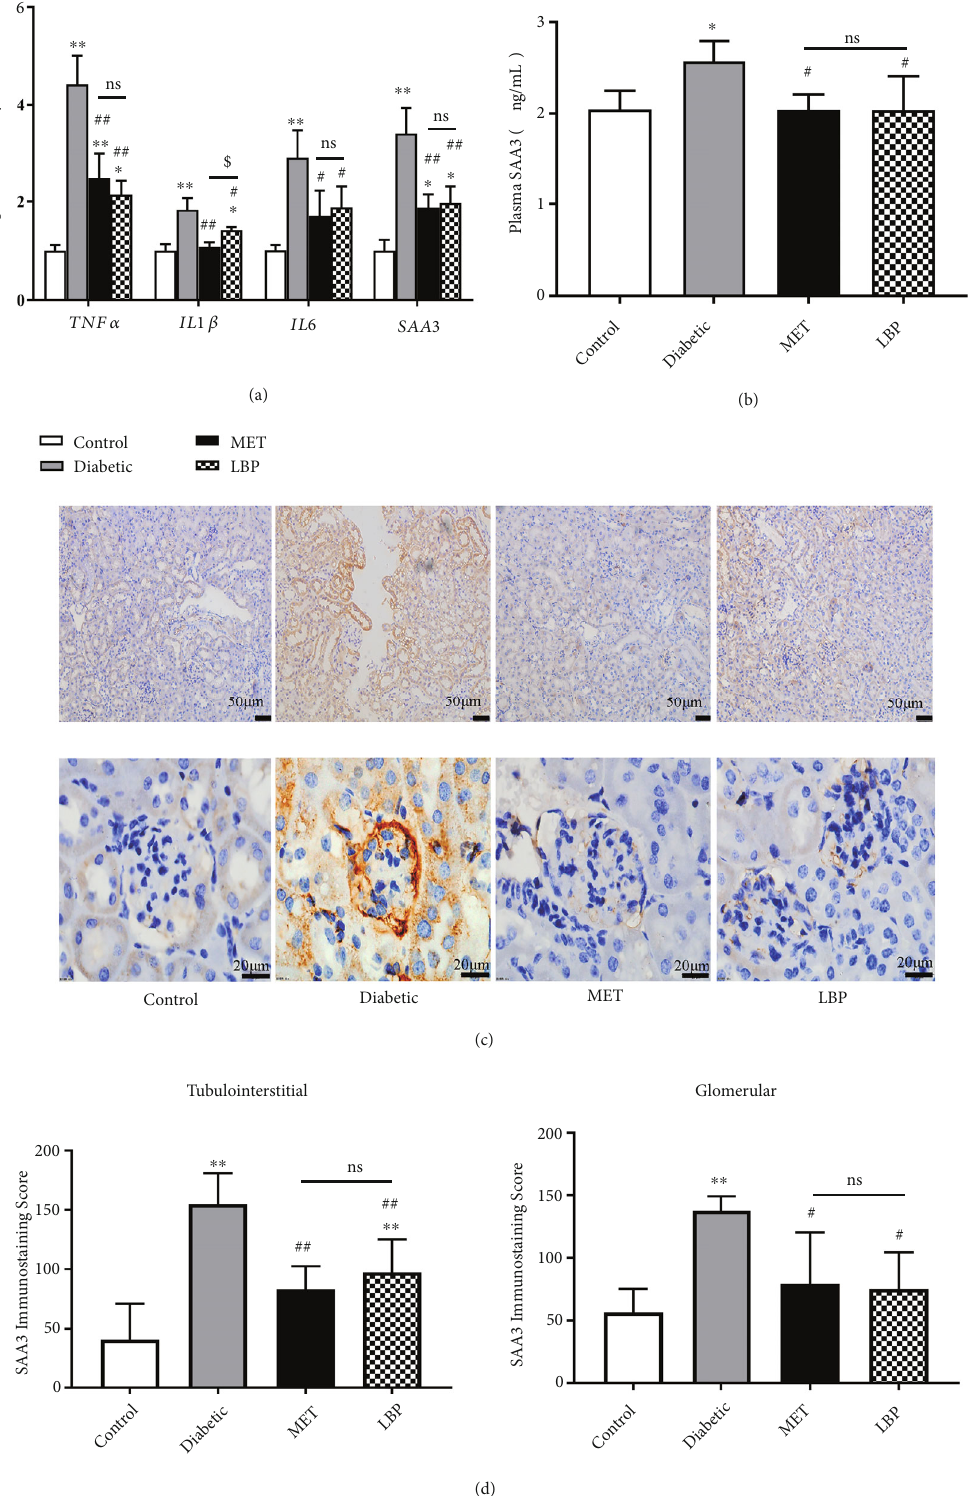
Figure 4: LBP inhibited the proin fl ammatory cytokine expression in diabetic mice: (a) the mRNA levels of TNF α , IL1b, IL6, and SAA3 in the kidney cortex; (b) the plasma level of SAA3; (c) the immunohistochemical analysis of SAA3 deposition in tubulointerstitium and glomerulus; (d) the quanti fi cation of SAA3 in the kidney by immunostaining scores. Data are expressed as the mean ± SD ( n = 6 -9 mice per group). ∗ Control vs. other groups, ∗ p < 0 : 05, ∗∗ p < 0 : 01 ; # diabetic group vs. other groups, # p < 0 : 05, ## p < 0 : 01 ; $ MET vs. LBP, $ p < 0 : 05, $$ p < 0 : 01 ; ns means no signi fi